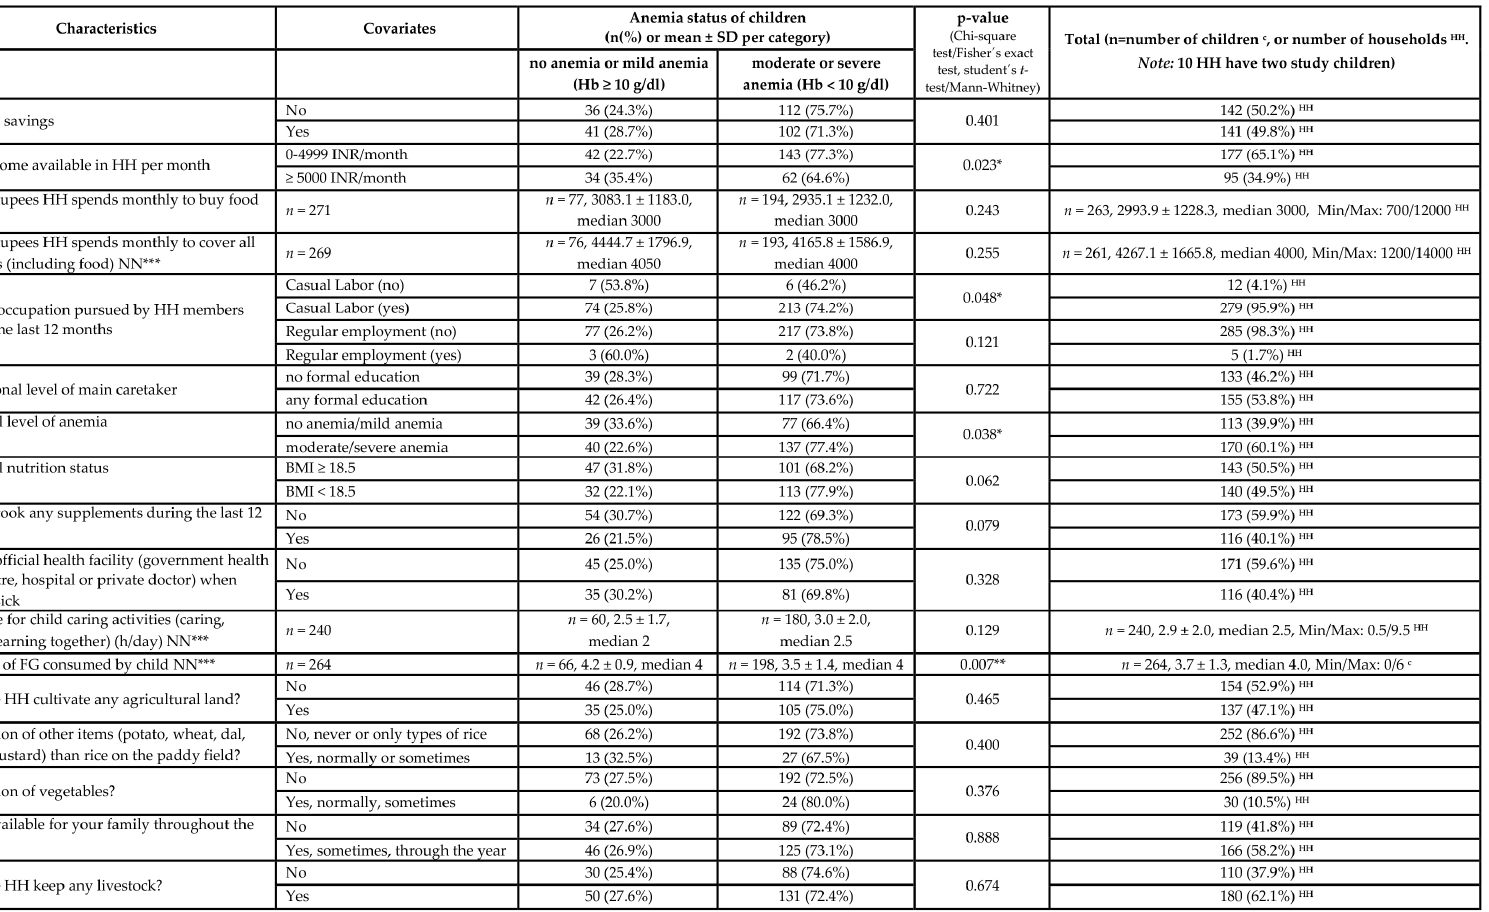
Table 7. Cont. Int. J. Environ. Res. Public Health 2019 , 16 ,